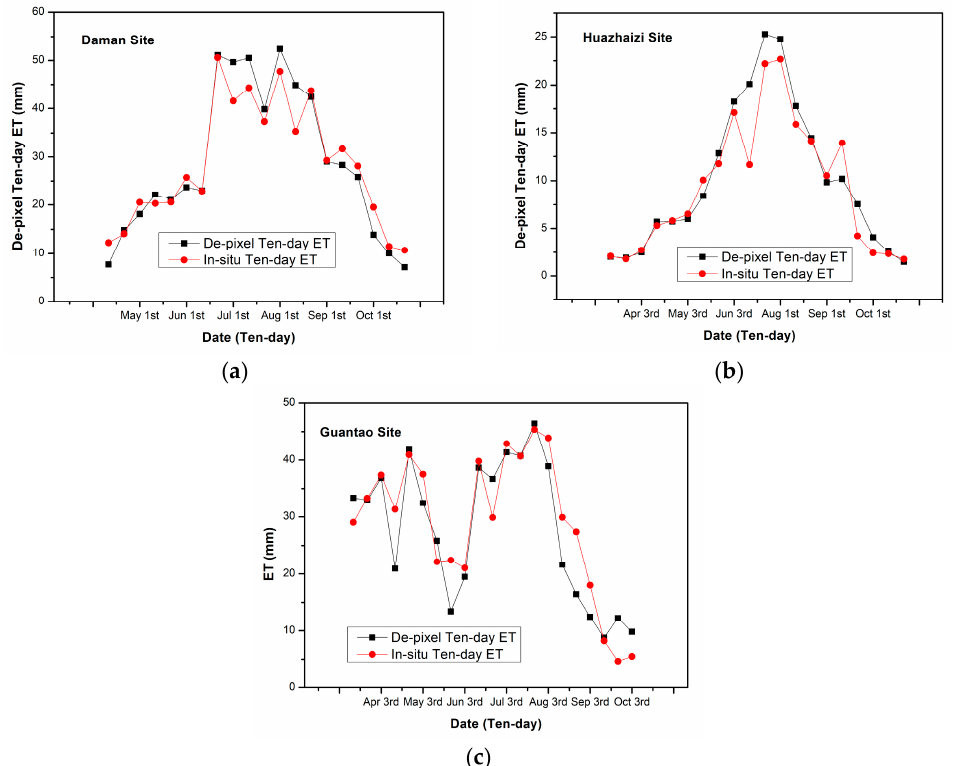
Figure 7. Progression of ten-day ET in 2013 at ( a ) Daman; ( b ) Huazhaizi; and ( c ) Guantao.